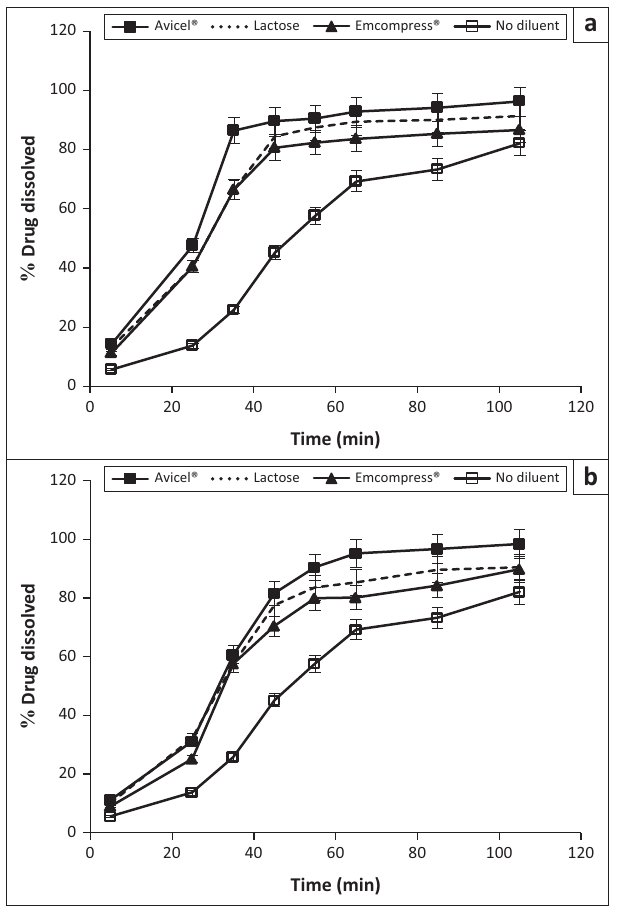
FIGURE 2: The dissolution profiles of Ficus exasperata herbal tablets having highest disintegration efficiency ratio. (a) drug–diluent ratio 1:4; (b) drug– diluent ratio